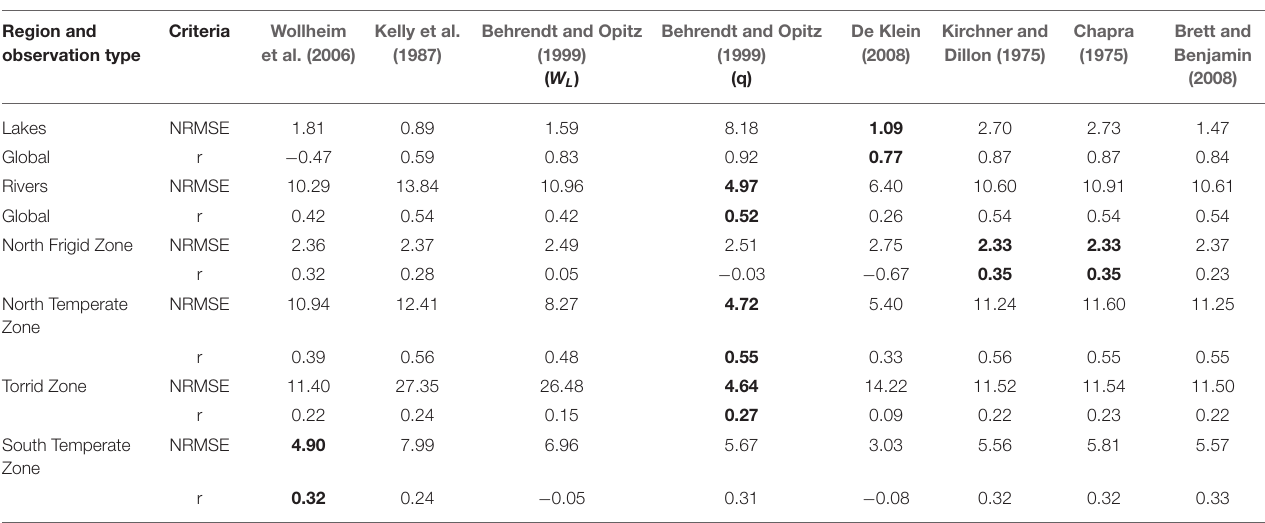
TABLE 3 | Assessment of the performance of P retention models for rivers and lakes. Region and observation type